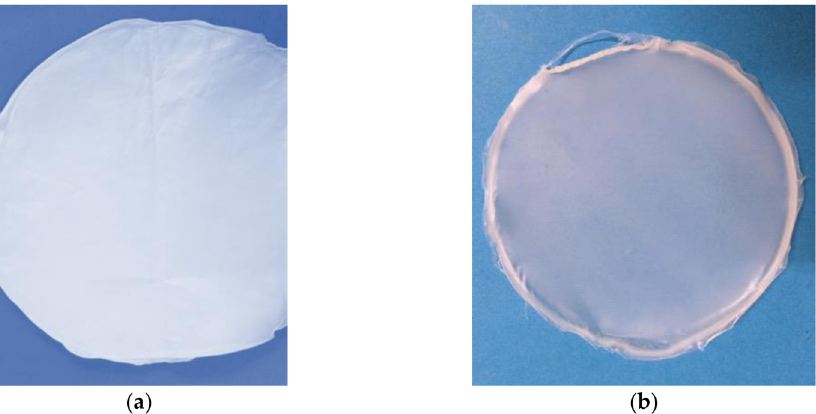
Figure 2. PCL 20% wt + PEG 10% wt films produced by ( a ) electrospinning and ( b ) solvent casting.